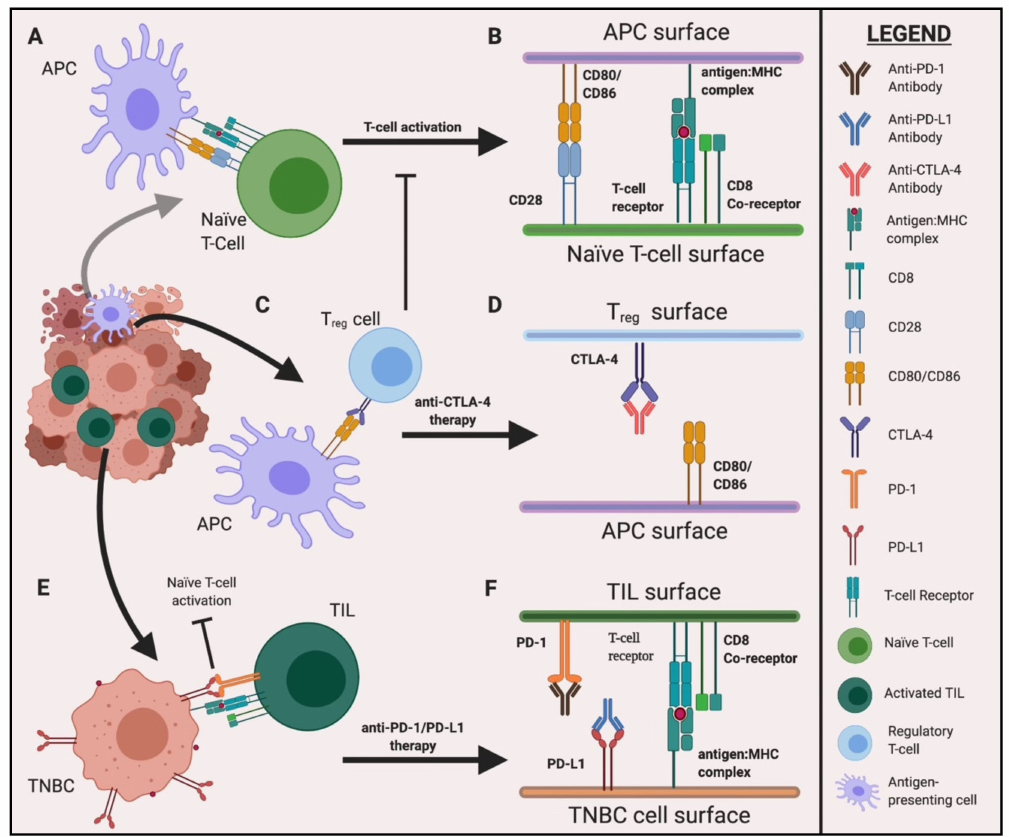
Figure 1. Possible mechanism of immune checkpoint inhibitors in triple-negative breast cancer (TNBC). Tumors consist of heterogenous cell populations including di ff erent types of immune infiltrating cells that undergo proliferation and apoptosis. ( A ) Tumor-infiltrating antigen-presenting cells (APCs) display tumor-associated antigens (TAAs) on their major histocompatibility complexes (MHC), which activate antigen-specific naïve T-cells. ( B ) Cluster of di ff erentiation 80 (CD80) on the APC and cluster of di ff erentiation 28 (CD28) are both co-signaling molecules necessary for T-cell activation and expansion. ( C ) CD80 molecules on tumor-infiltrating APCs preferentially bind to cytotoxic T lymphocyte protein-4 (CTLA-4), constitutively expressed on regulatory T cells (T reg ) that commonly recruit myeloid-derived suppressor cells (MDSCs) to the tumor microenvironment (TME) to inhibit T-cell activation. ( D ) Anti-CTLA-4 antibodies inhibit T reg activation and enhance anti-tumor activity. ( E ) Tumor cells express programmed death ligand-1 (PD-L1) and tumor-infiltrating lymphocytes express its receptor, PD-1. The interaction between PD-1 and PD-L1 inactivates T-cell activation / expansion within the TME. ( F ) Anti-PD-1 or anti-PD-L1 antibodies prevent PD-1 / PD-L1 engagement, thereby inhibiting the suppressive signals and promoting anti-tumor immunity. Figure created with